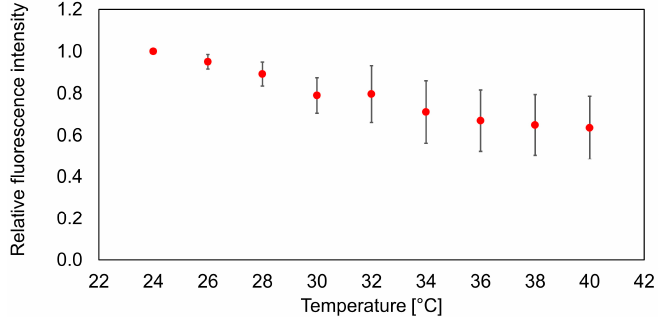
Figure 6. Measurement of fluorescence intensity vs. temperature to construct a calibration curve. The error bars represent the standard deviation of average fluorescence intensity from nine stained nanosensors.